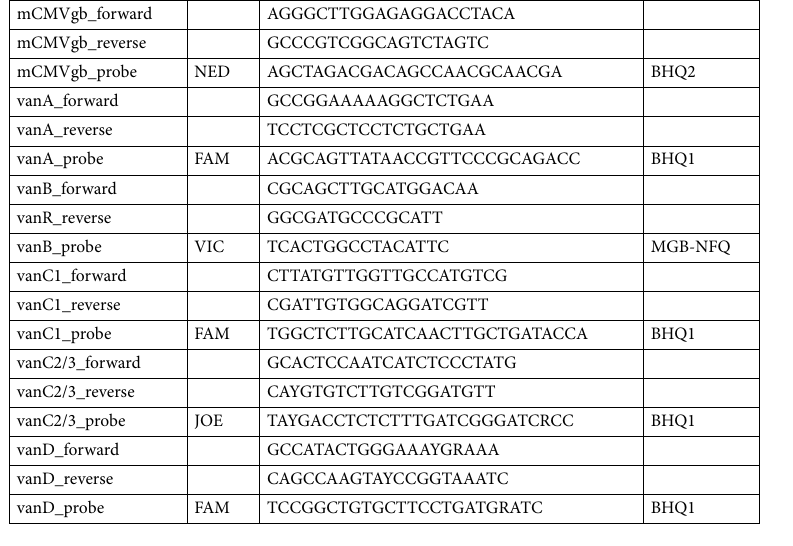
Table 3. List of primers and probes used in this